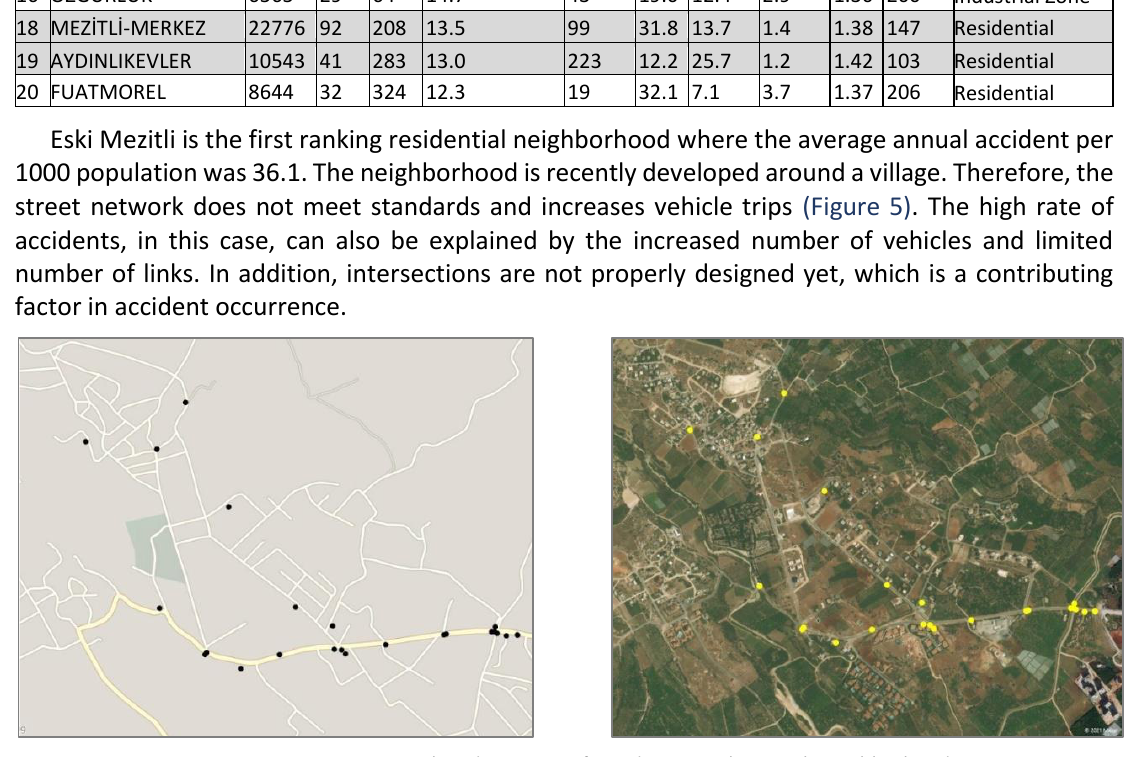
Figure 5 Street Network and Location of Accidents in Eski-Mezitli Neighborhood